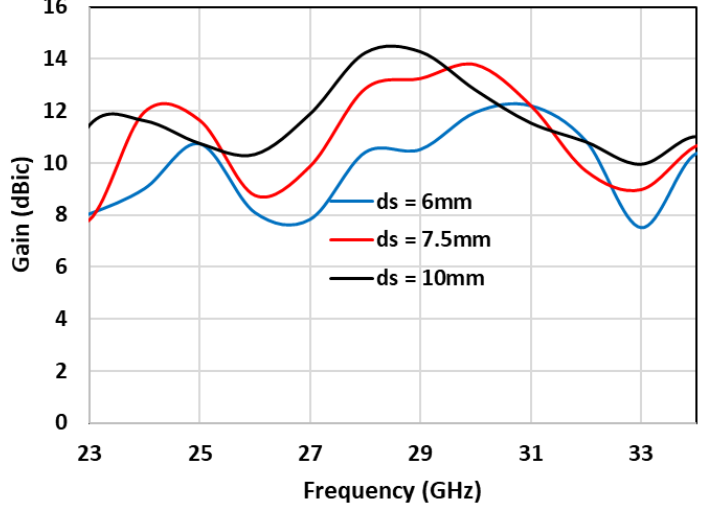
Figure 8. Axial ratio of the DRA array using various separation distances (d s ) between the DRAs.